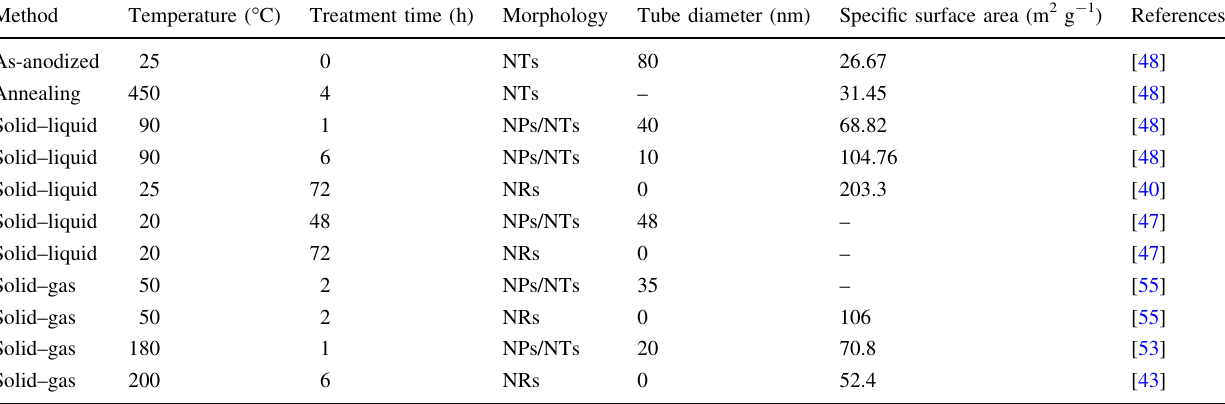
Table 1 Experimental parameters and their influence on TNTs properties of WAC methods